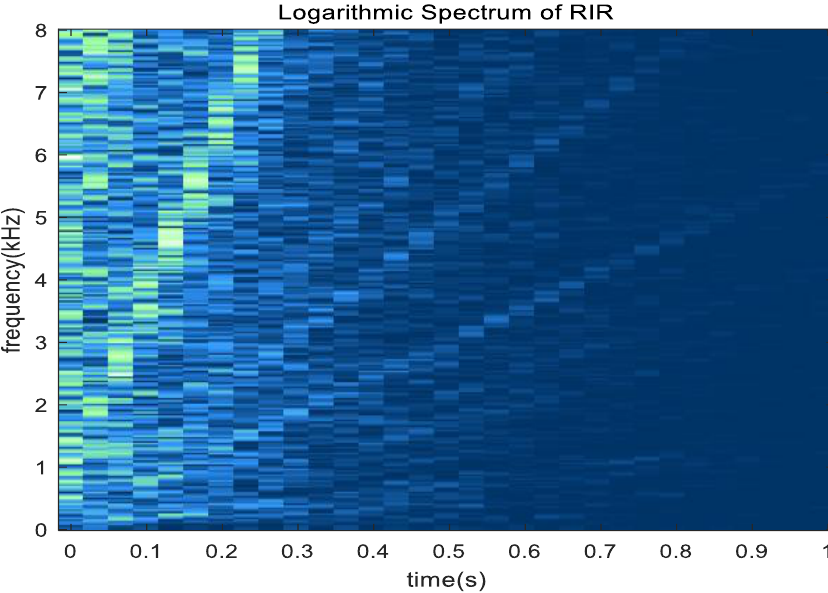
Figure 3. Logarithmic spectrum of an RIR signal with T 60 = 600